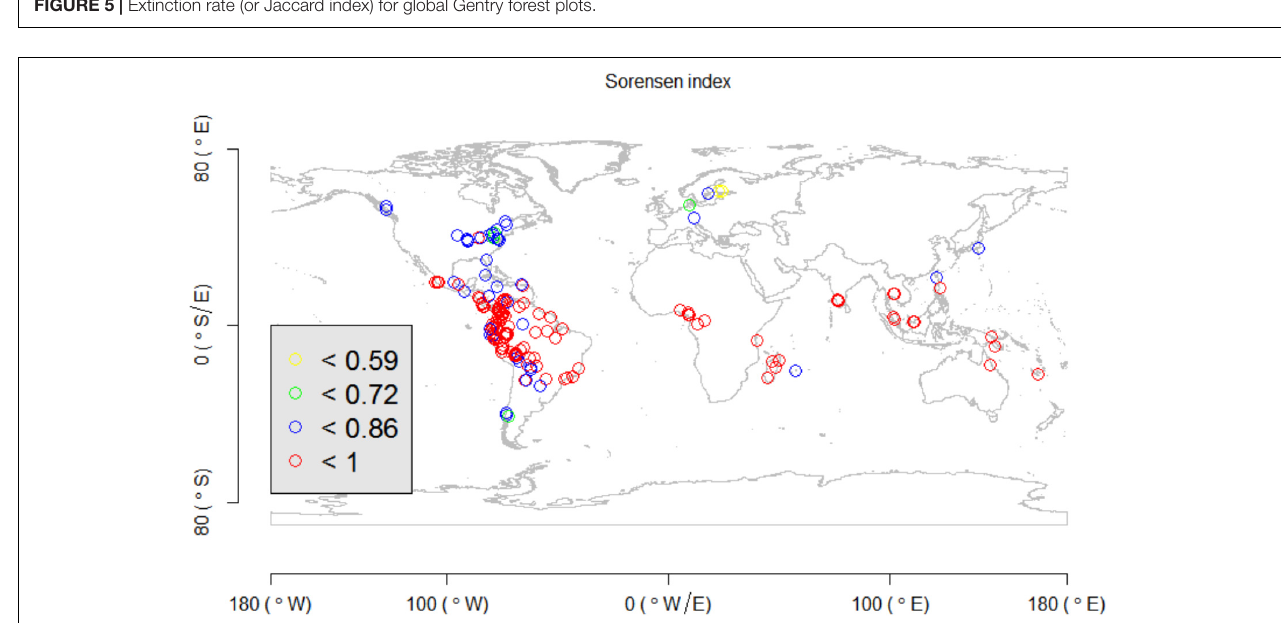
FIGURE 5 | Extinction rate (or Jaccard index) for global Gentry forest plots.